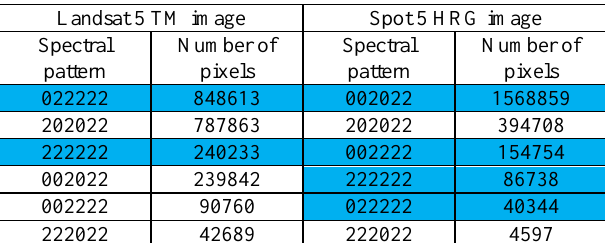
Table. 2 Statistics on spectral patterns and number of pixels for each spectral pattern for Landsat 5 TM and Spot 5 HRG image of study area. Colour shaded rows indicate spectral patterns for water.